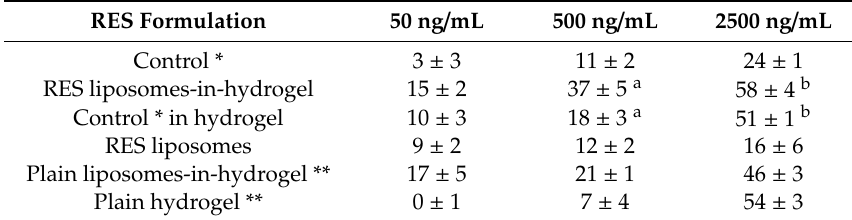
Table 2. E ff ect of RES formulations on the NO production expressed as the percentage of reduction ( n = 3). Concentration of formulations is expressed as RES concentrations (50, 500 and 2500 ng /